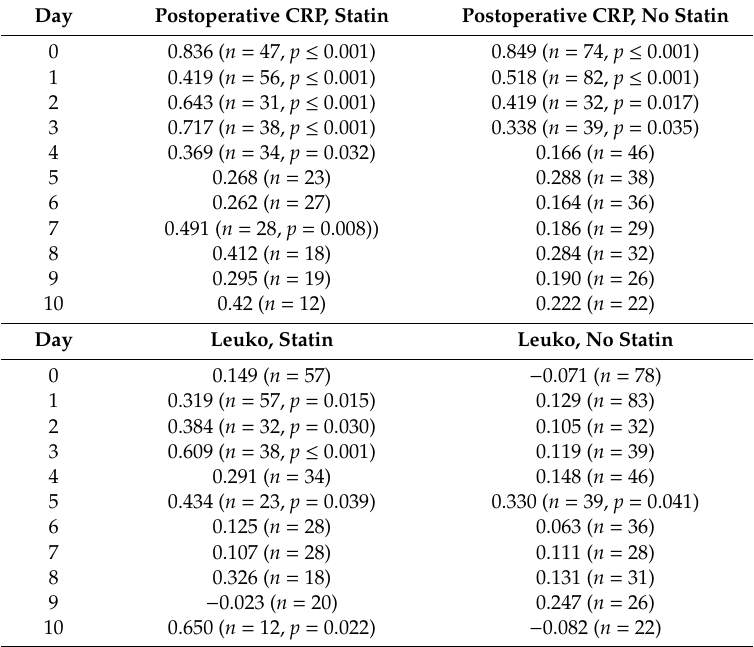
Figure 4. Patients stratified according to statin intake: linear regression analyses of preoperative levels of C-reactive protein (CRP) with postoperative CRP levels ( a , b ), blood leukocyte counts ( c , d ) or fever ( e , f ). Patients who underwent pulmonary resection were investigated retrospectively and data collected on the first ( a , c , e ) and the second ( b , d , f ) postoperative day are depicted. Preoperative CRP values were obtained within 7 days before surgery. The solid line represents the best fit line for data patients treated with statins and the dashed line for those of patients who do not take statins. r, correlation coefficient; R 2 , coefficient of determination. Table 6. Subgroup correlation analysis, male patients regarding statin medication.